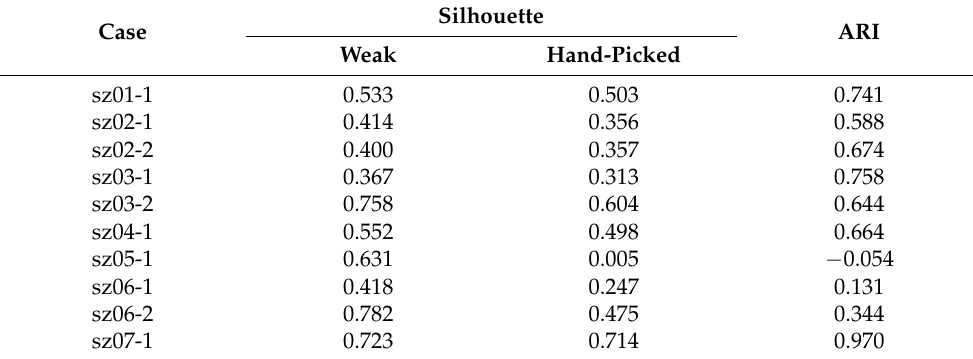
Table 3. Silhouette and ARI